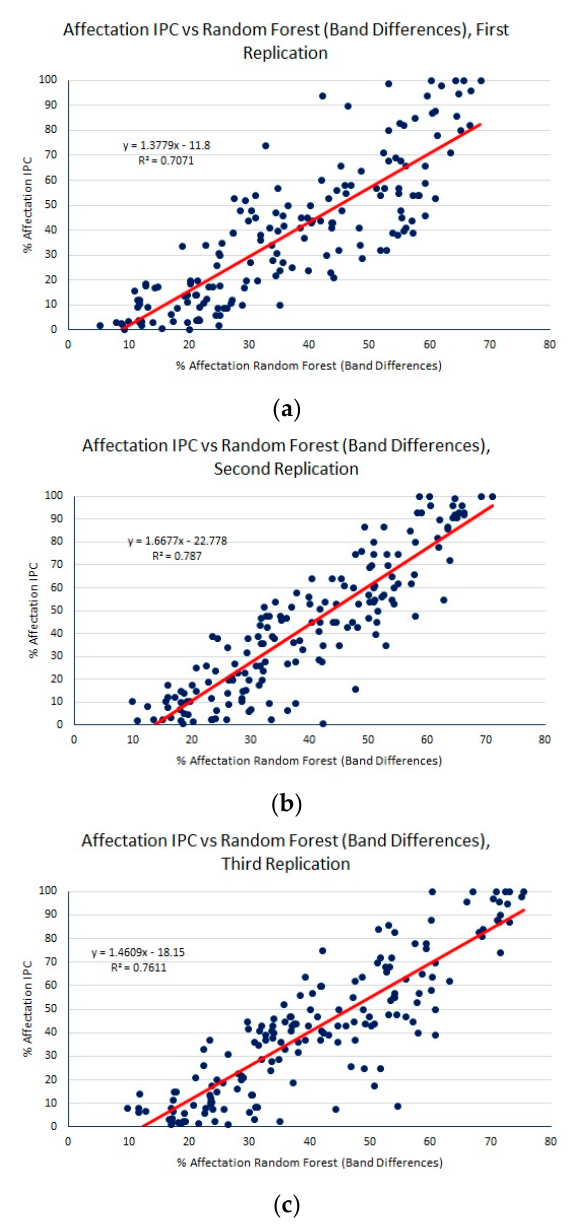
Figure 10. Percentage of P. infestans affectation using IPC methodology vs. estimated percentage of affectation using RFs on the band differences dataset, for ( a ) first replication, MAE: 13.04, RMSE: 15.98, R 2 : 0.7071; ( b ) second replication, MAE: 12.81, RMSE: 16.16, R 2 : 0.7870; ( c ) third replication, MAE: 13.02, RMSE: 16.31, R 2 : 0.7611. RF: Random Forests.